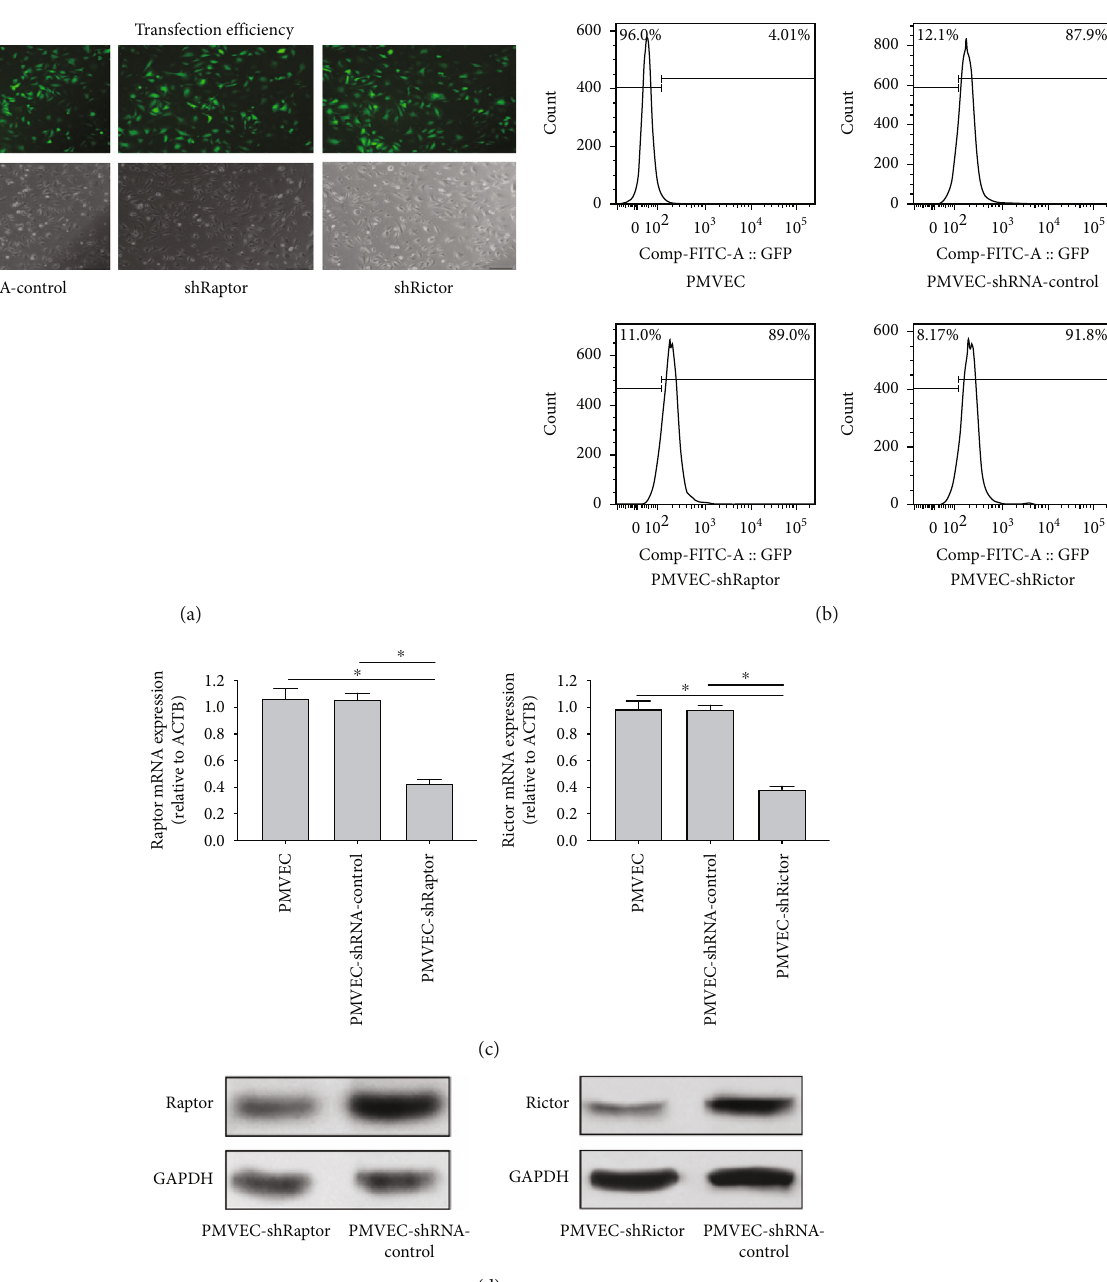
Figure 2: Conduction of lentivirus vector-mediated mTORC1 (raptor) and mTORC2 (rictor) knockdown in PMVECs. (a) Transfection e ffi ciency of shRaptor and shRictor in PMVECs with a fl uorescence microscope ( × 200). (b) Transfection e ffi ciency of shRaptor and shRictor in PMVECs with fl ow cytometry analysis. (c) RT-PCR analysis for relative raptor and rictor mRNA expression in PMVECs with gene knockdown. (d) WB analysis for relative raptor and rictor protein level in PMVECs with gene knockdown. Results are mean ± SD ( n = 3 ). ∗ p < 0 : 05